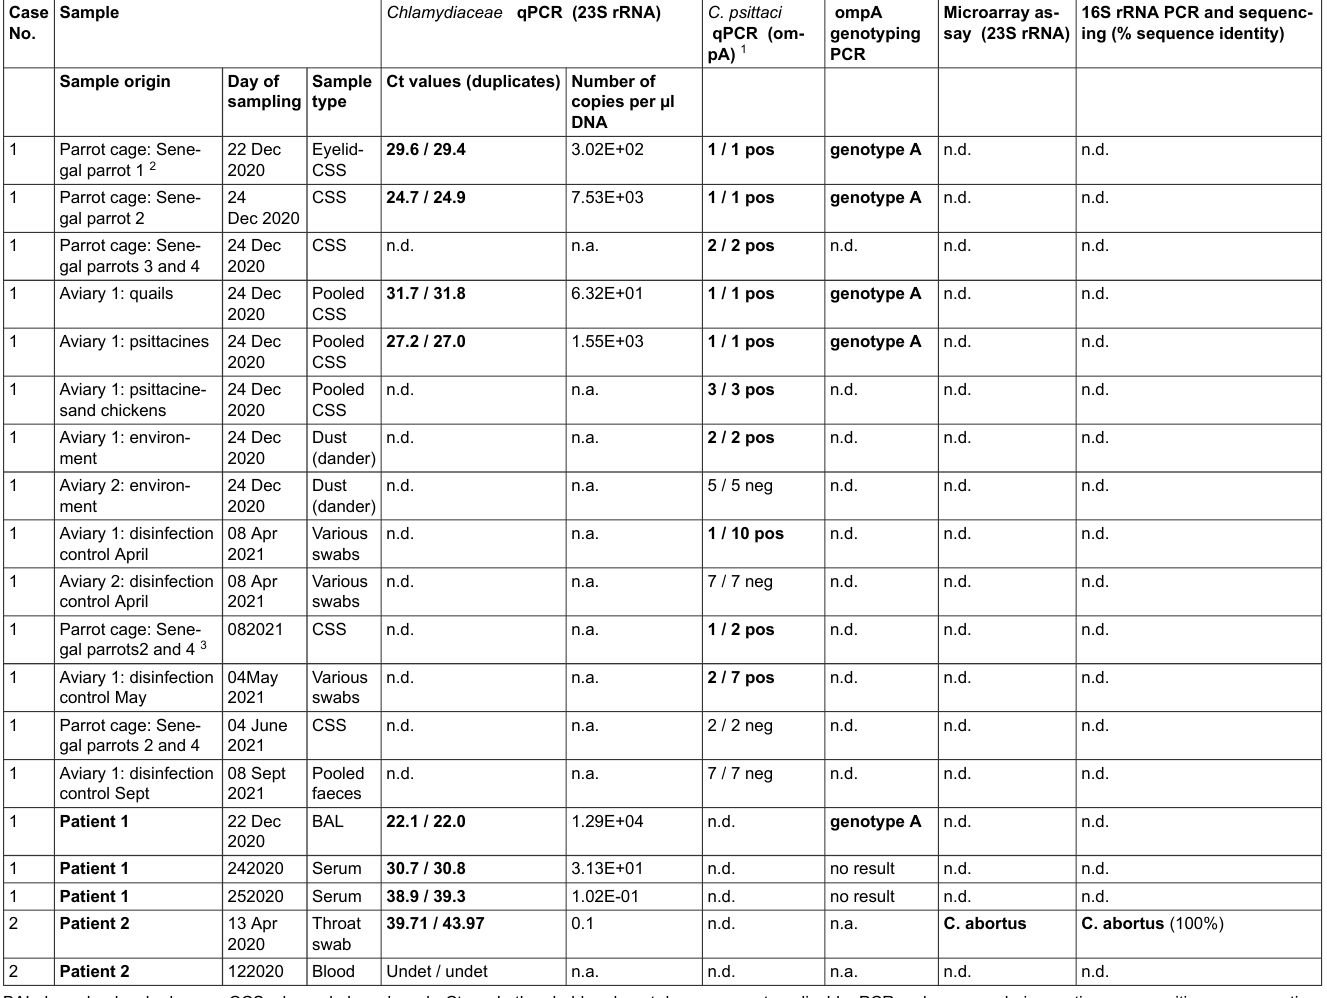
Table S2: Detailed results of different molecular tests using a step-wise approach for the detection and identification of Chlamydia in human (patient 1 and 2) and bird samples from Switzerland. Case No.